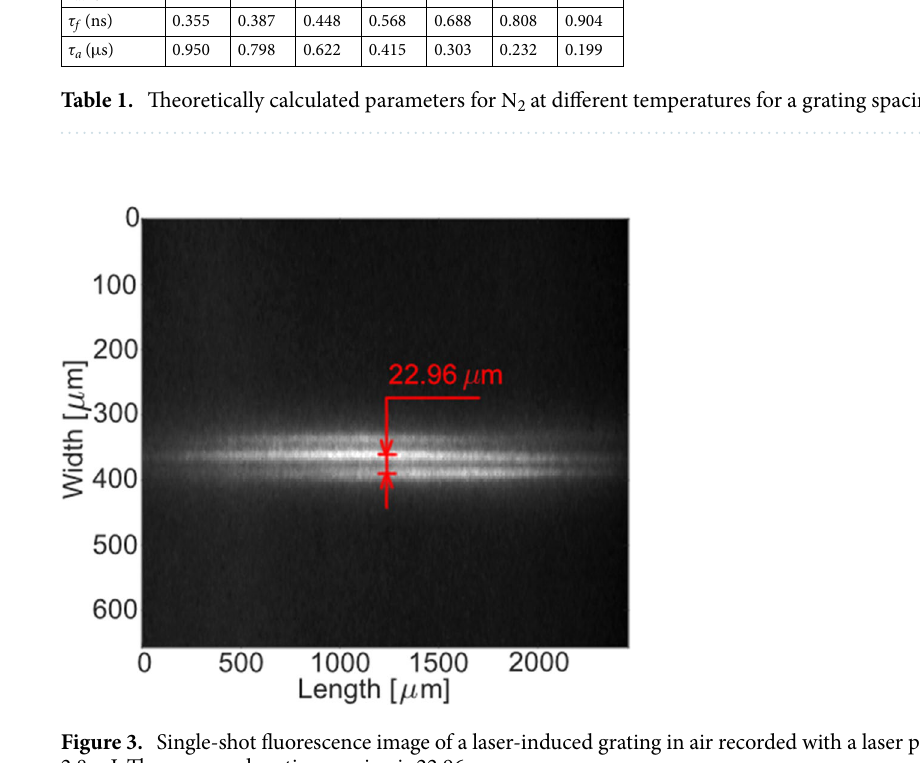
Figure 3. Single-shot fluorescence image of a laser-induced grating in air recorded with a laser pulse energy of 2.8 mJ. The measured grating spacing is 22.96 µ